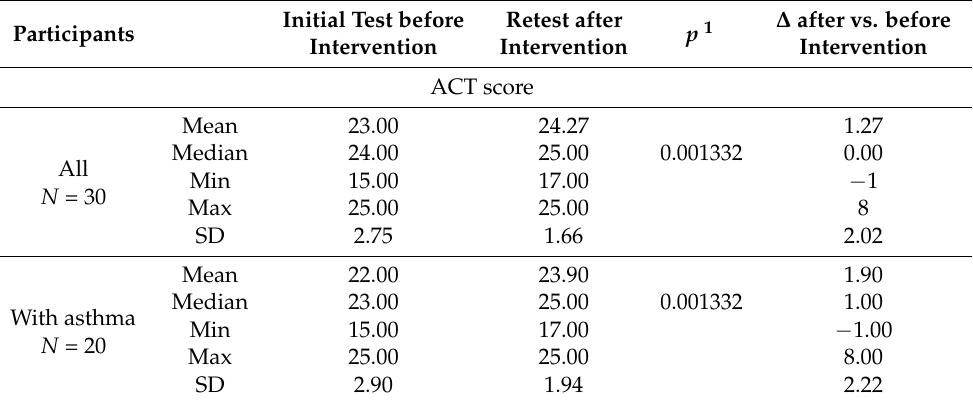
Table 4. Comparison of the ACT scores, the SNOT-22 scores and the four-item itch questionnaire scores before and after dietary